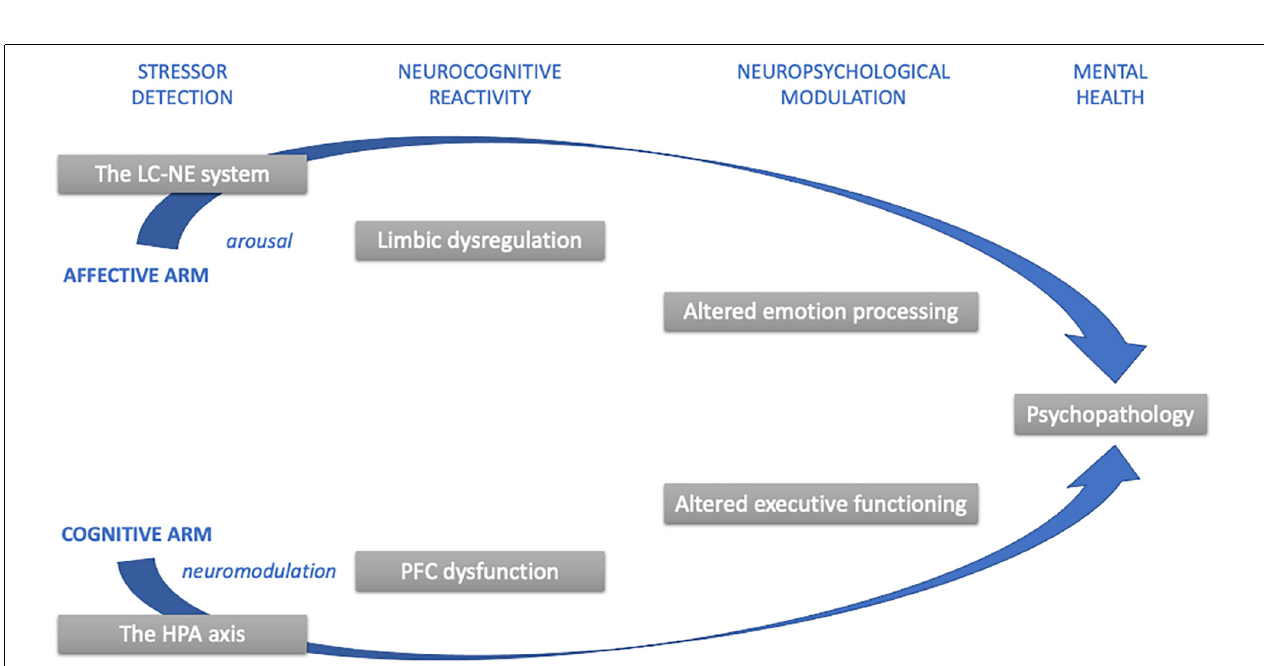
which cannot be supported by a mood-congruent memory